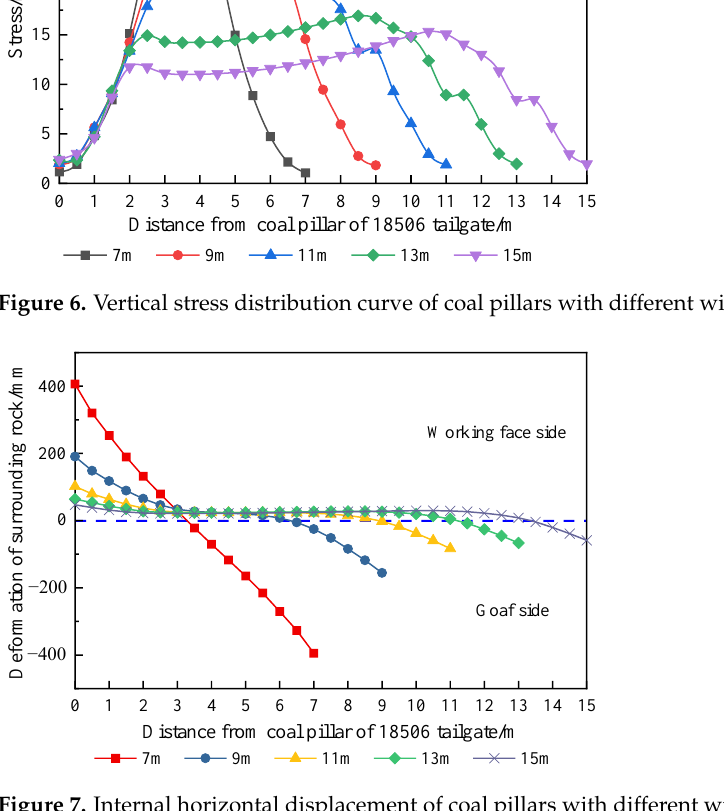
Figure 7. Internal horizontal displacement of coal pillars with different widths during mining.